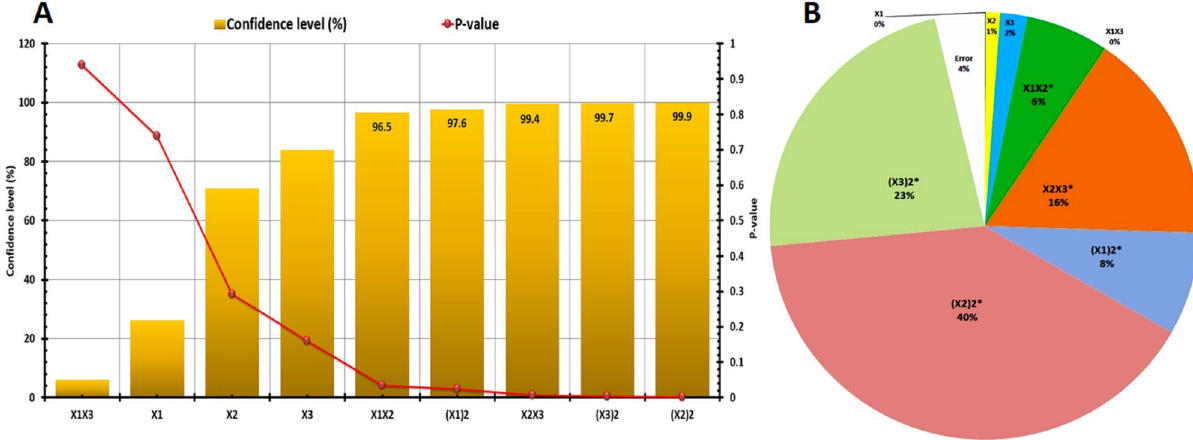
Figure 8. Statistical analysis of effects of tested significant variables on dry cell mass of entophytic Trichodermavirens strain EG92, according to Box–Behnken experimental design. ( A ) Pareto chart represents the calculated p -value and confidence level (%), and ( B ) Pie chart shows percent distribution of each